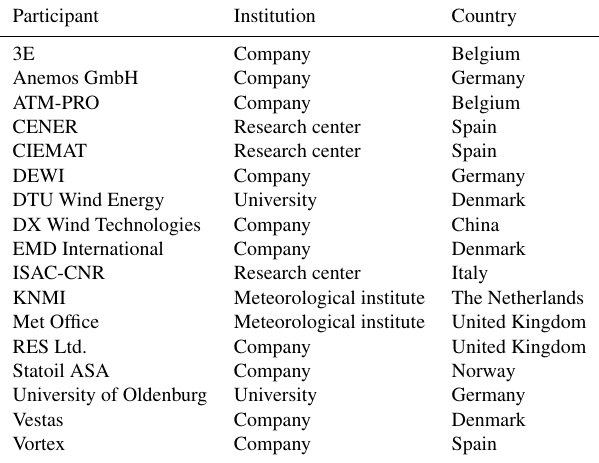
Table 3. Participants in the study in alphabetical